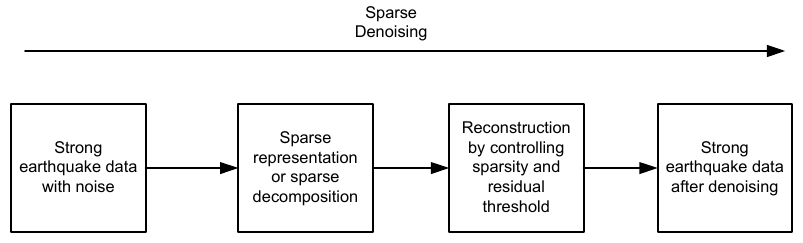
Figure 1. Process Flow of Strong Earthquake Data Denoising Based on Sparse Representation.